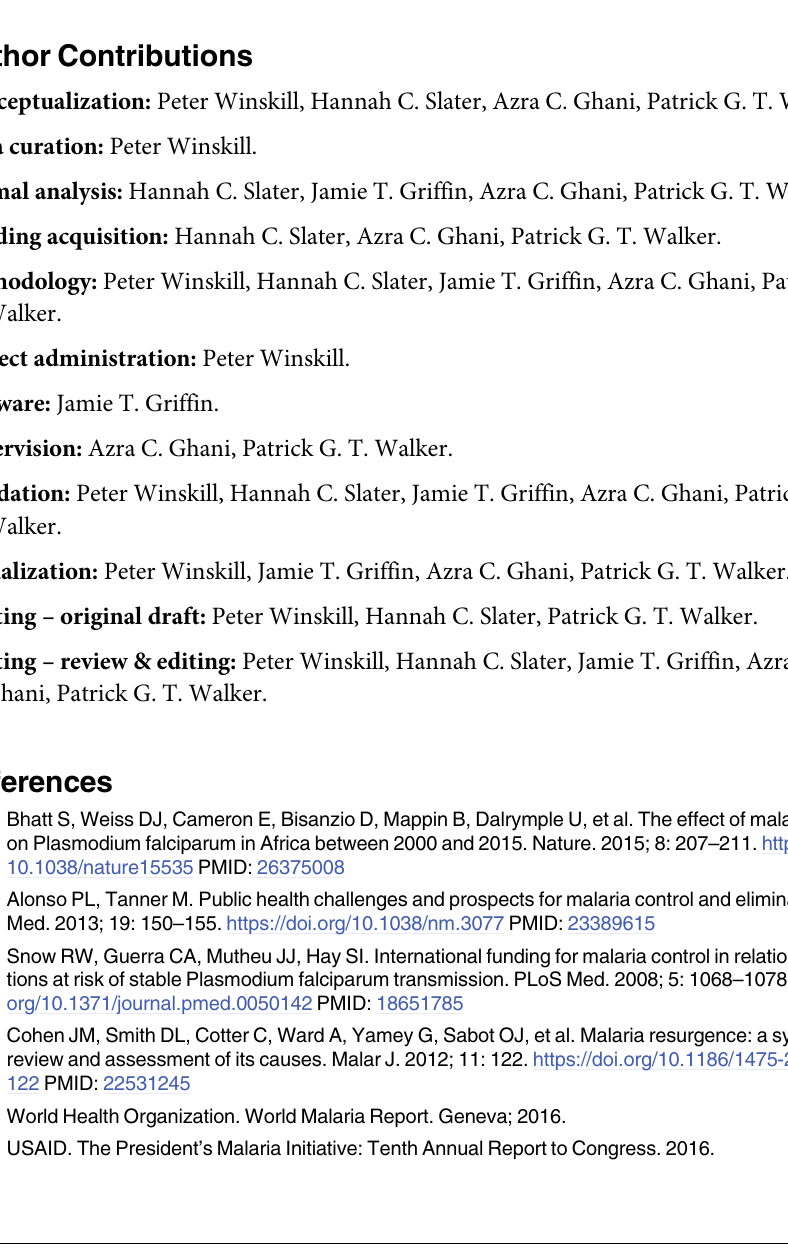
S2 Table. First administrative unit